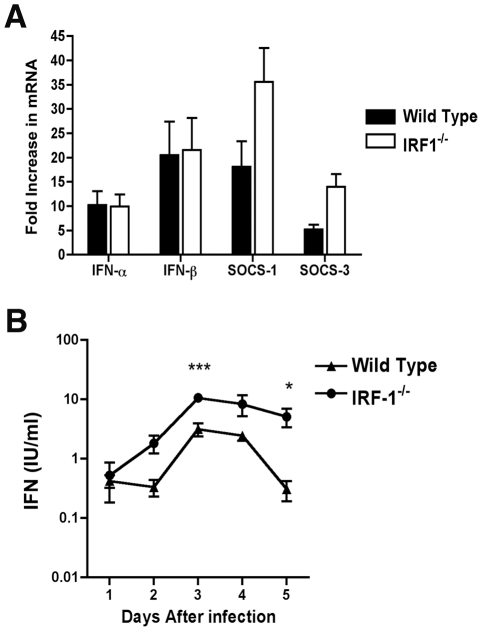
IFN-dependent responses in lymph node and serum of wild type and IRF-1
-/- mice infected with WNV.
A. Mice were inoculated with 102 PFU of WNV by footpad injection and sacrificed at 2 days post infection. After harvesting of the draining inguinal lymph node, IFN-α, IFN-β, SOCS-1, and SOCS-3 mRNA levels were measured by quantitative RT-PCR and compared to mock-infected animals. B. Type I IFN levels were determined from serum collected on days 1 through 5 after WNV infection of wild type or IRF-1
-/- mice by an EMCV bioassay in L929 cells. Data reflect averages of serum samples from 3 to 7 mice per time point and the data are expressed as international units (IU) of type I IFN per ml. The specificity of the assay was confirmed with an anti-IFN-αβR neutralizing antibody (data not shown). Asterisks indicate values that are statistically significant (***, P<0.001; *, P<0.05).